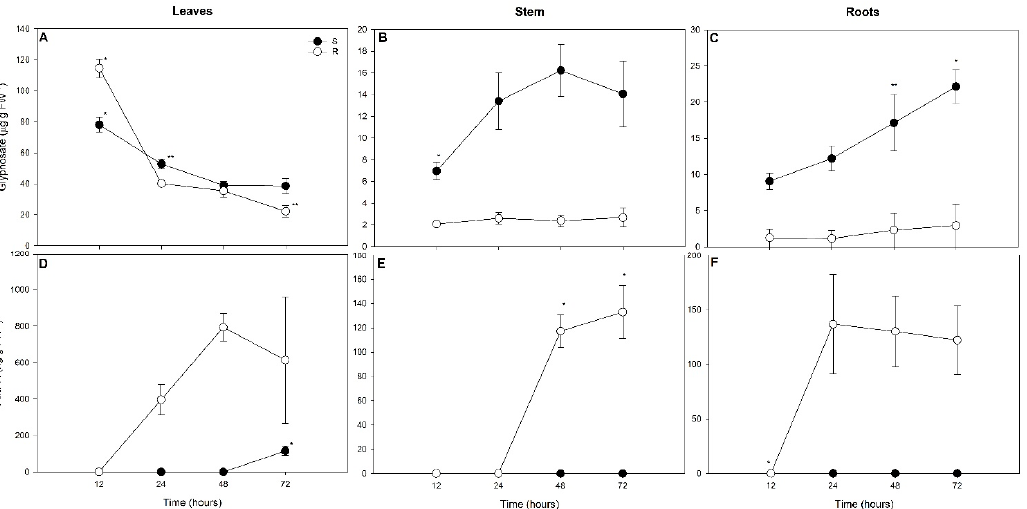
Figure 3. Glyphosate and AMPA concentrations in the leaves ( A , D ), stems ( B , E ), and roots ( C , F ) of glyphosate susceptible (S) and resistant (R) Conyza spp . plants exposed to 0 (-Gly) or 1080 g glyphosate (a.e.) ha − 1 (+Gly) for 72 h. Values are represented as the mean ± standard error of five replicates. * , ** indicates significant differences between times with the same biotype and glyphosate concentrations, by the Contrast test (considering p < 0.05).